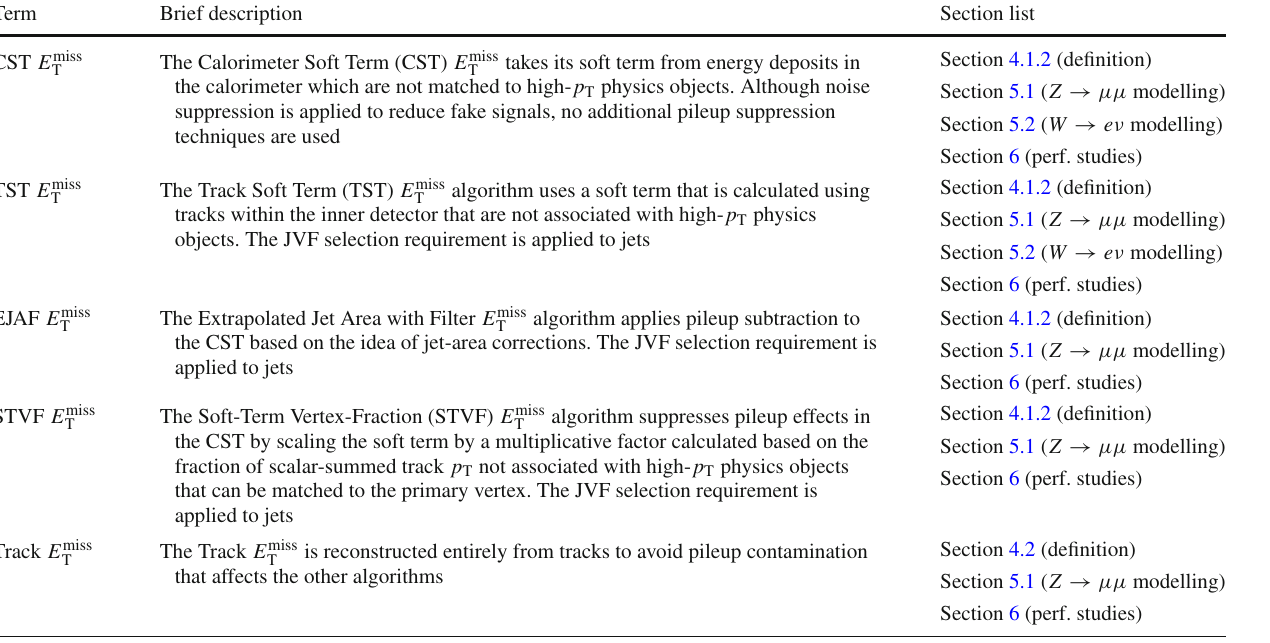
Table 3 Summary of E miss